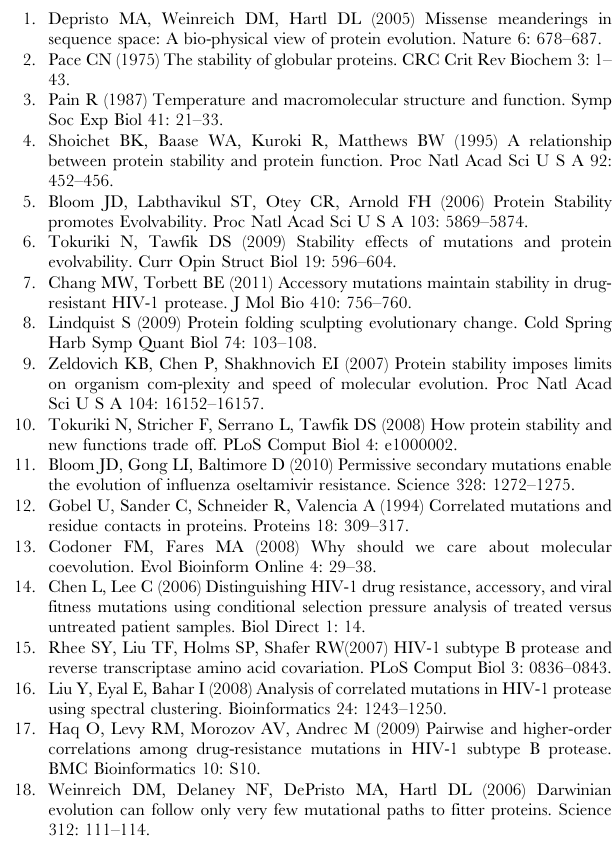
Table S3 The most statistically deviated pairs of mutations. The 10 most statistically deviated double mutations in the Lee database relative to the independent model. The measure used to test for deviation is dev ( i , j ) ~ (cid:3) 2 where P ij ( M , M ) is the joint P ij ( M , M ) probability of a double mutation at positions i and j while P i ( M ) is the univariate marginal of a mutation at position i . The double mutant charge states and the distance between charges is also listed. (PDF) Text S1 Text S1 consists of the supplementary infor- mation to the main text. In this supplementary information, we describe our algorithm in greater